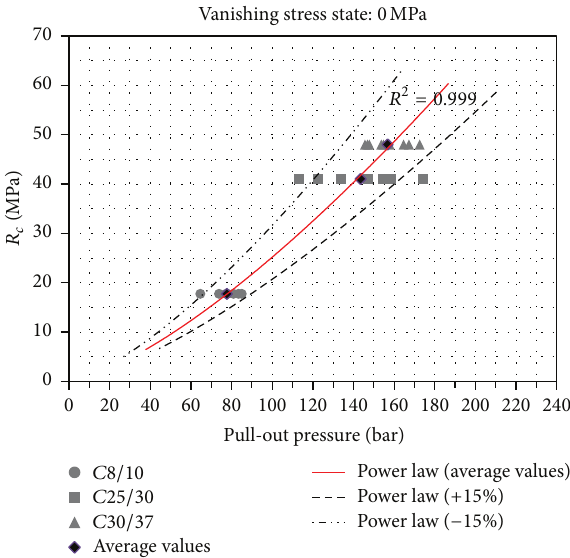
Figure 14: Calibration curve for vanishing stress.